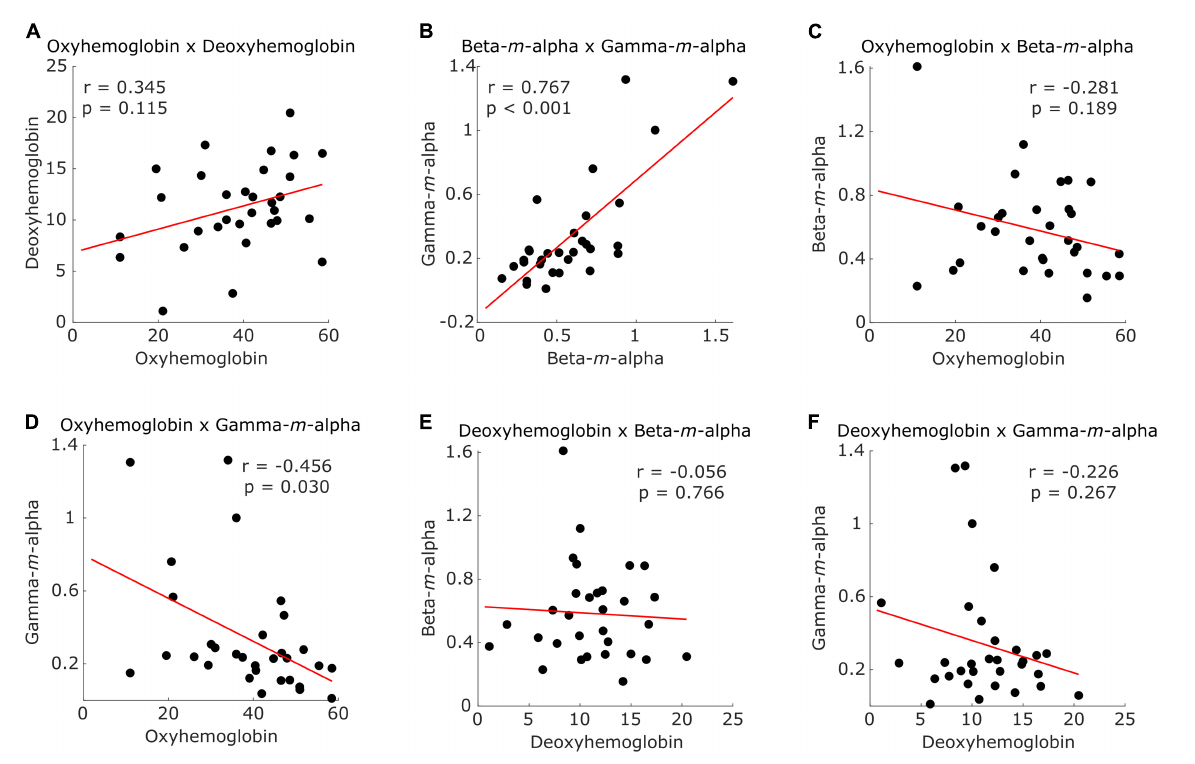
FIGURE5 Scatter plots illustrating participants (dots) distribution according to (A) CSS from fNIRS oxyhemoglobin and deoxyhemoglobin, (B) CSS from EEG beta - m -alpha and gamma- m -alpha, (C) CSS from fNIRS oxyhemoglobin and EEG beta- m -alpha, (D) CSS from fNIRS oxyhemoglobin and EEG gamma- m -alpha, (E) CSS from fNIRS deoxyhemoglobin and EEG beta- m -alpha, and (F) CSS from fNIRS deoxyhemoglobin and EEG gamma- m -alpha. Red line represents the